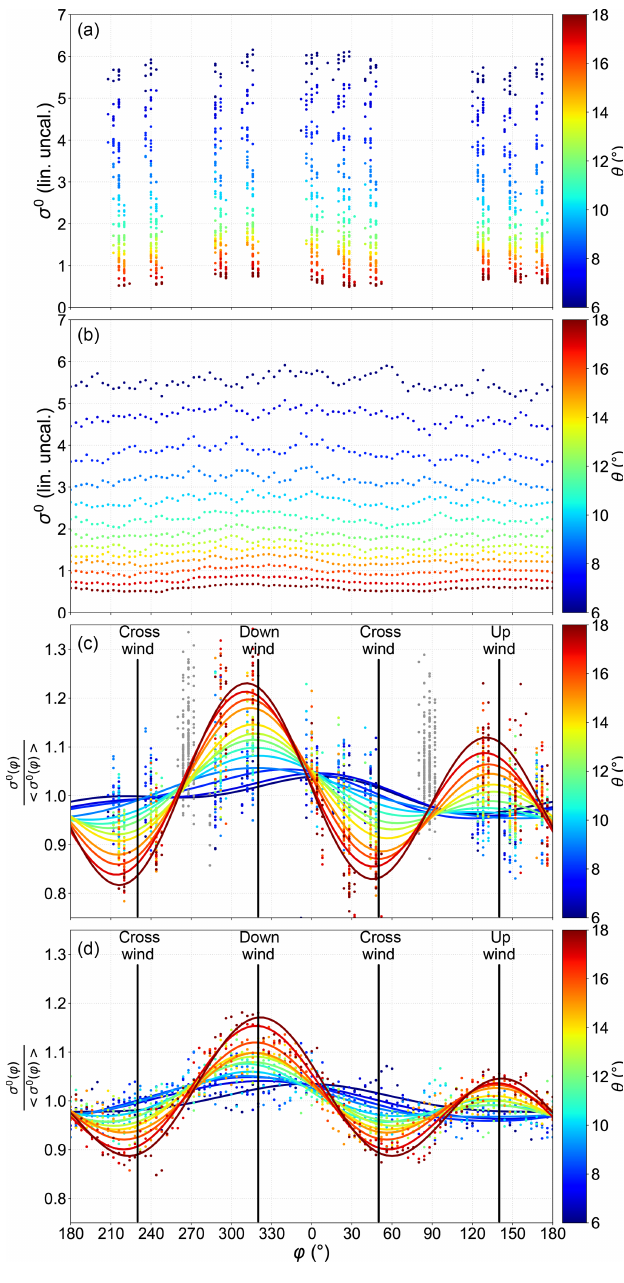
Figure 10. (a, b) Variations as a function of azimuth ϕ of σ 0 for an incidence angle θ of 6 to 18 ◦ on 22 November for the port-looking (12:13–13:38UTC) and rotating-antenna (13:41– 13:58UTC) flights, respectively. (c, d) Variations of σ 0 normalized by its azimuthal average for the fixed- and rotating-antenna data,